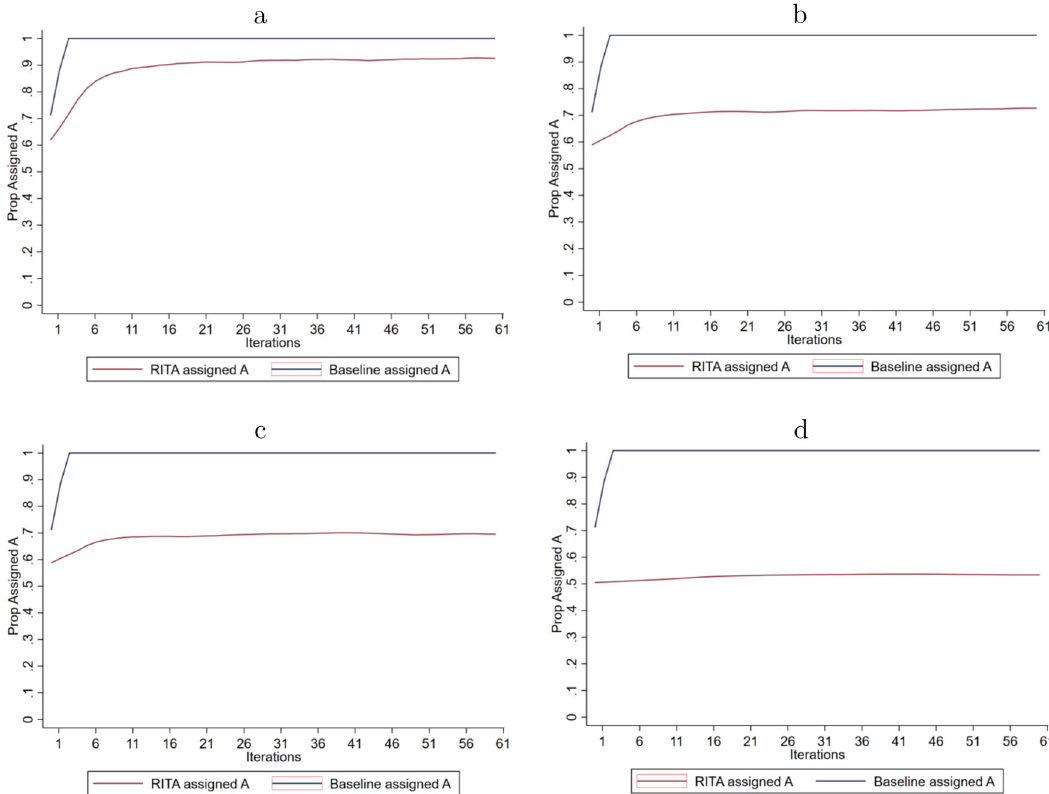
Fig. 3 Longitudinal treatment assignment. a Results for World 1. b Results for World 2. c Results for World 3. d Results for World